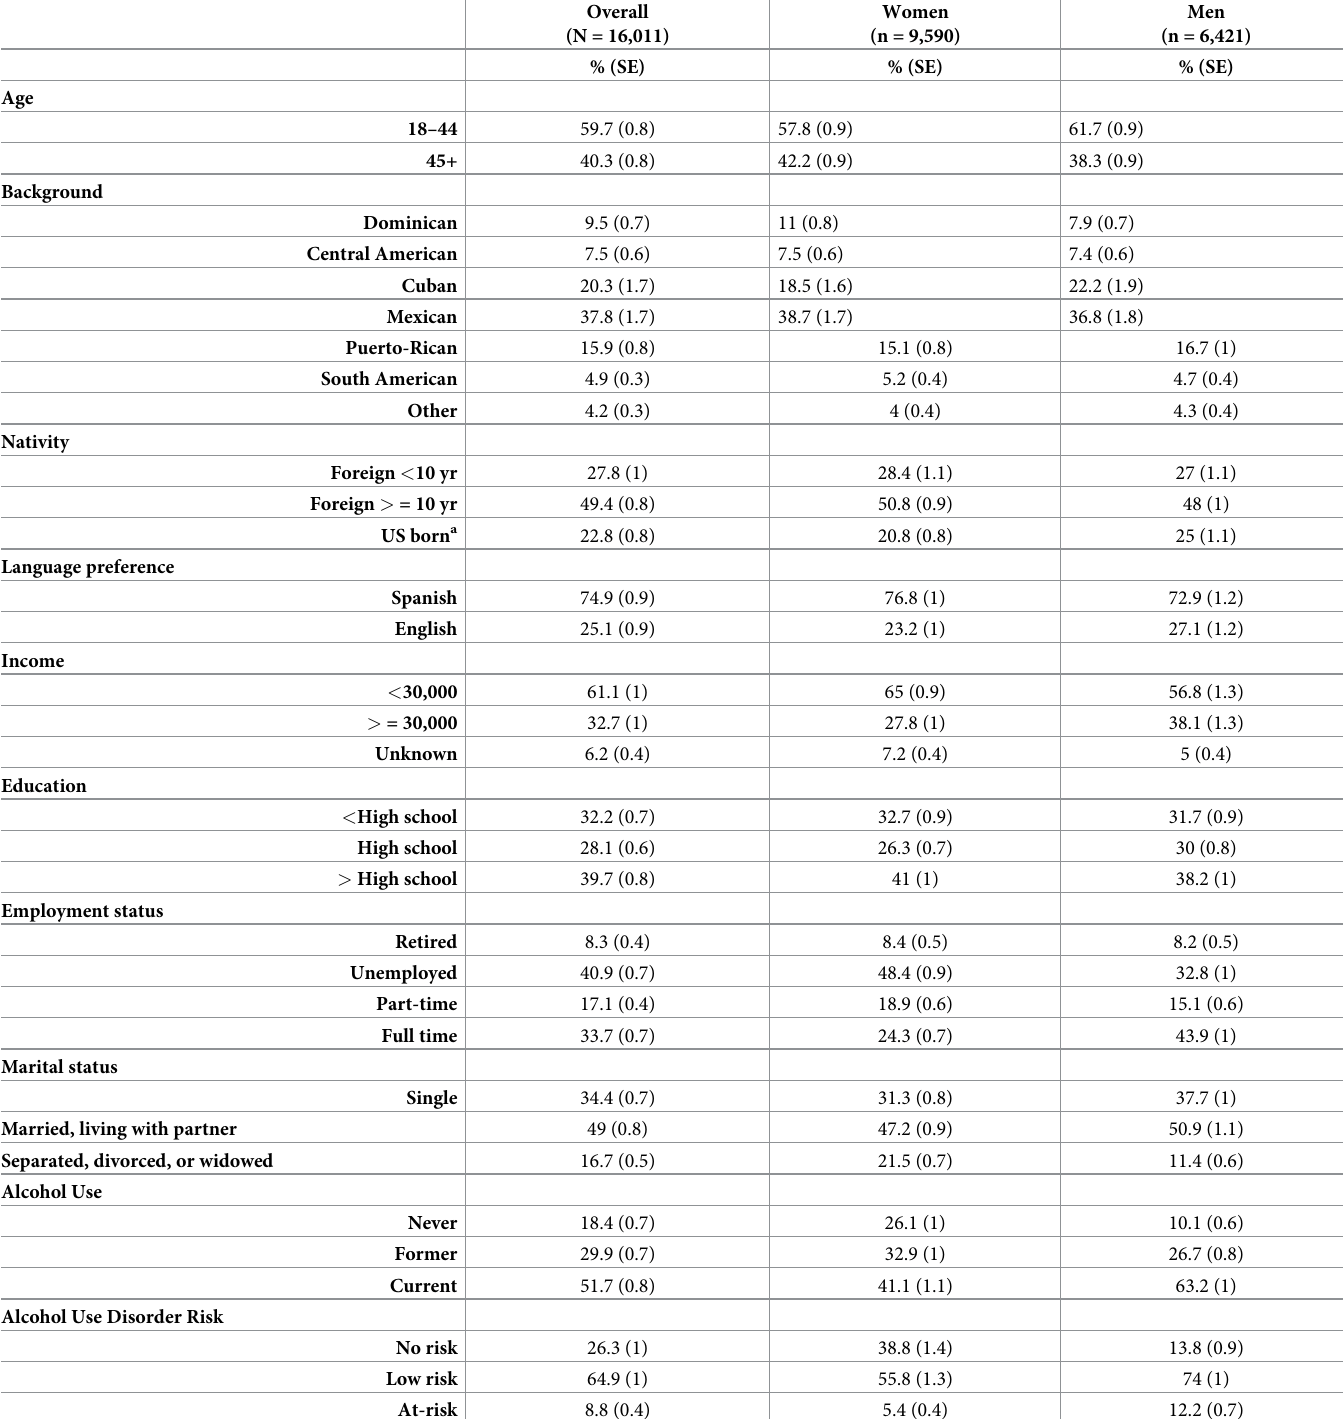
Table 1. Sample socio-demographic characteristics, overall and by sex (n =